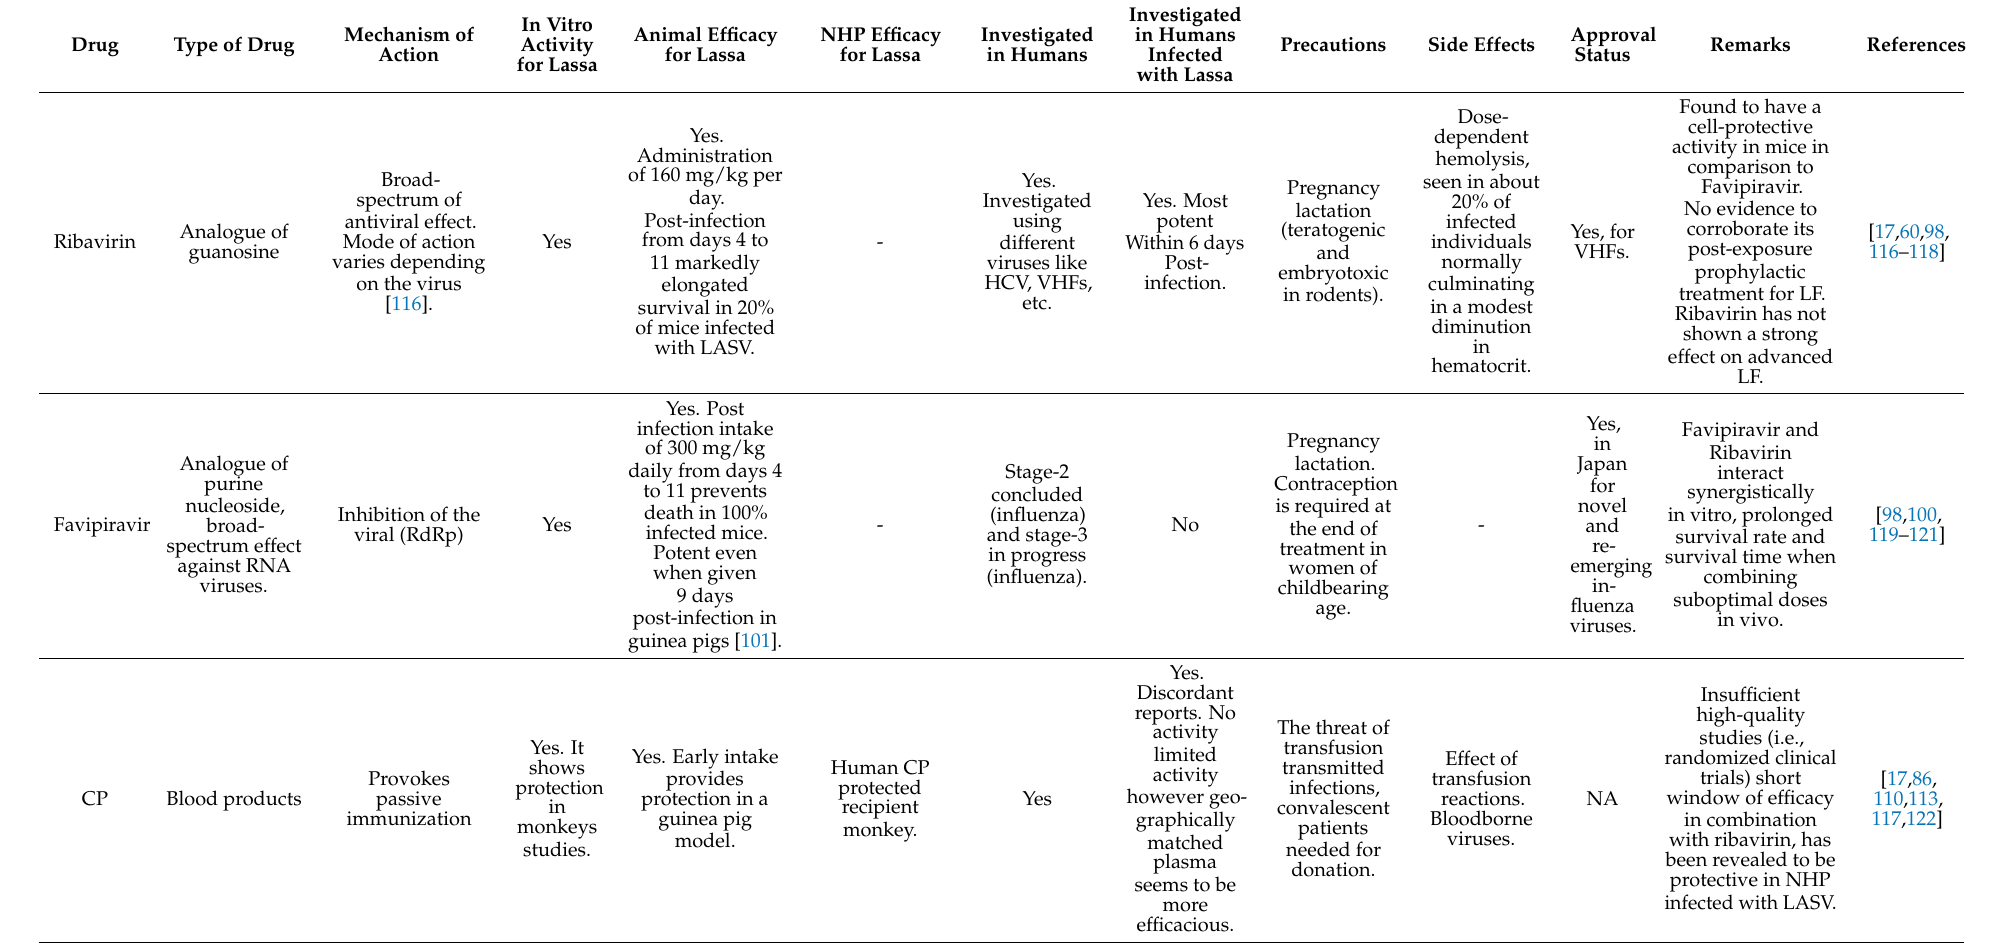
Table 1. Summary of previous studies/trials and details of possible